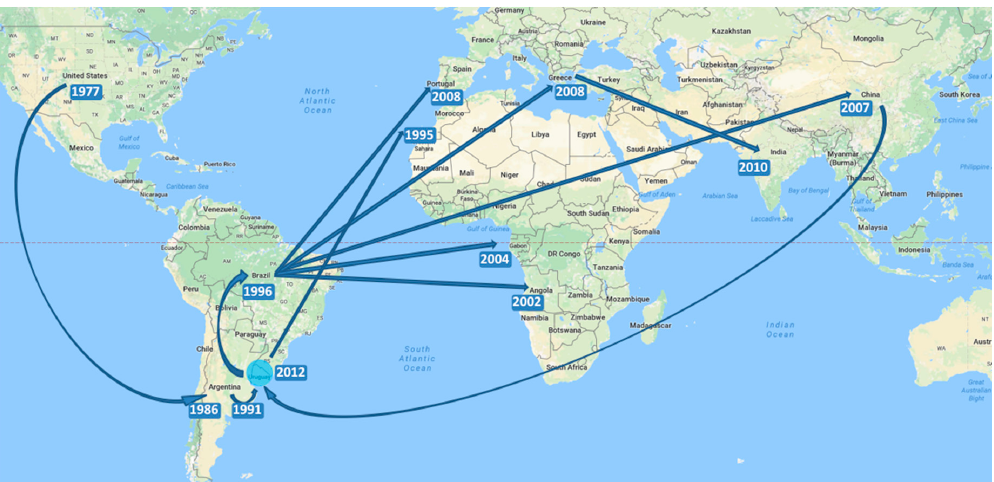
Figure 2. Spatiotemporal dynamics of CTV-NC genotype circulating in the world. Dispersal pattern (blue arrows) between 1977 and 2015, reconstructed from the MCC tree and the probably year of arrival to each country (blue squares with the year) are shown. The local expansion occurred in Uruguay is shown (light blue circle). Map was adapted from Google Maps ® (Google®, Mountain View, California, United States).